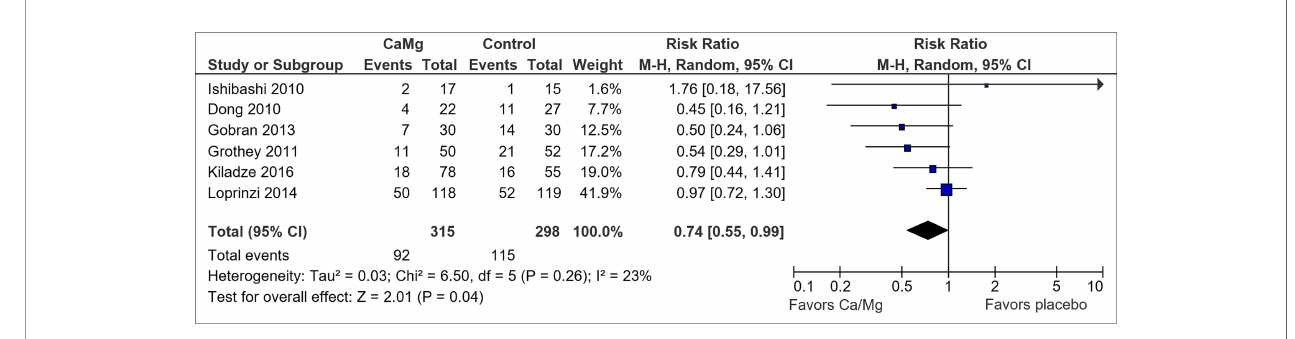
FIGURE 3 | Forest plot for comparison of the incidence of OIPN of CTCAE grade ≥ 2: Ca/Mg versus placebo.